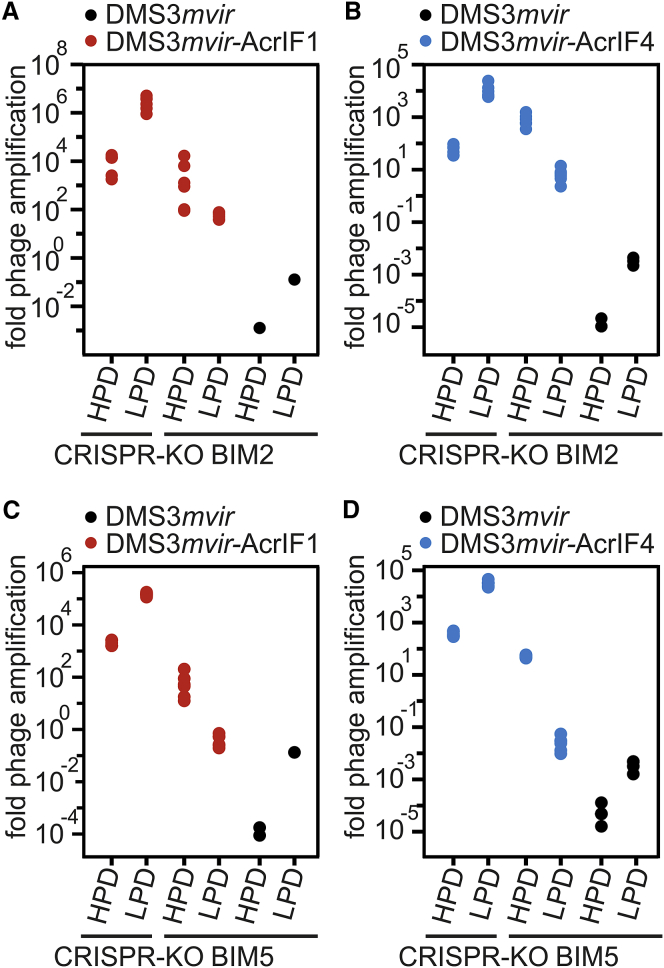
Acr-Phage Amplification Is Density Dependent(A) Fold phage amplification at 24 hpi with 106 pfus DMS3mvir (black data points) or DMS3mvir-AcrIF1 (red data points) of PA14 CRISPR-KO (sensitive) or BIM2 under either high phage densities (HPD, 6 mL culture) or low phage densities (LPD, 600 mL culture).(B) Fold phage amplification at 24 hpi with 108 pfus DMS3mvir (black data points) or DMS3mvir-AcrIF4 (blue data points) of PA14 CRISPR-KO (sensitive) or BIM2 under either HPD or LPD.(C) Fold phage amplification at 24 hpi with 107 pfus DMS3mvir (black data points) or DMS3mvir-AcrIF1 (red data points) of PA14 CRISPR-KO (sensitive) or BIM5 under either HPD or LPD.(D) Fold phage amplification at 24 hpi with 108 pfus DMS3mvir (black data points) or DMS3mvir-AcrIF4 (blue data points) of PA14 CRISPR-KO (sensitive) or BIM5 under either HPD or LPD; each data point represents an independent biological replicate (n = 6). The limit of detection is 200 pfu/ml.See also Figure S3 and Table S1.